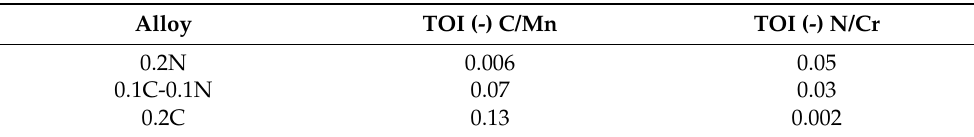
Table 2. Theoretical ordering index (TOI) of Fe-15Cr-7Mn-4Ni-0.5Si-(0.01-0.2)N-(0.01-0.2)C steels for the complexes C-Mn and